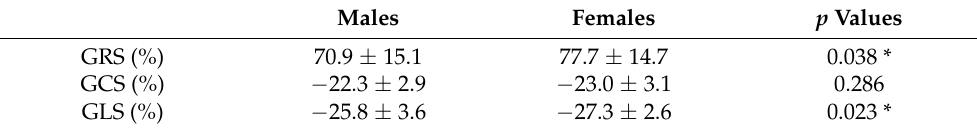
Table 4. Global myocardial strain of the left ventricle in different genders. Males Females p